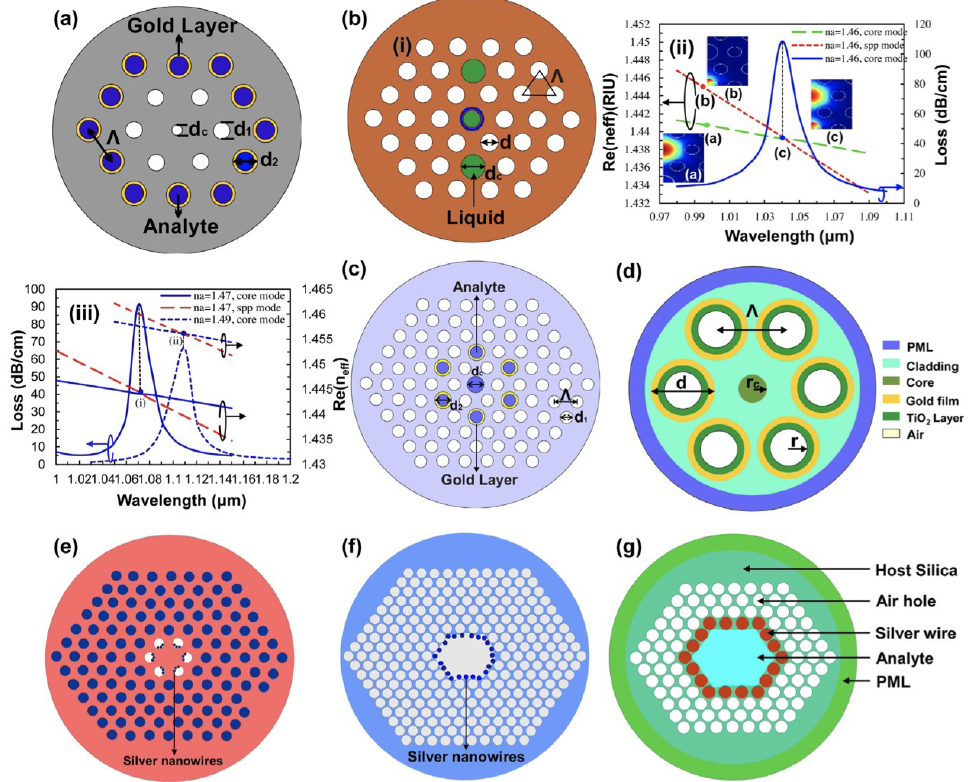
Figure 7. Metal coating-based plasmonic PCF sensors. ( a ) gold coated in the second ring ( d c = 0.45 Λ , d 1 = 0.6 Λ , d 2 = 0.8 Λ , Λ = 2 µm and gold layer thickness equal to 40 nm); ( b ) ( i ) selectively silver deposited core ( d c = 0.8 Λ , d 1 = 0.6 Λ , d 2 = 0.8 Λ , Λ = 2 µm and silver layer thickness equal to 40 nm), ( ii ) field distribution with phase matching phenomena; and ( iii ) phase matching phenomena shifted with varying analyte RI. ( c ) Selectively gold-coated with liquid-filled core ( d c = 0.8 Λ , d 1 = 0.5 Λ , d 2 = 0.8 Λ , Λ = 2 µm and gold layer thickness, t = 40 nm); ( d ) multiple holes coated with gold-TiO 2 layer ( r c = 3.5 µm, r = 6 µm, Λ = 13 µm, gold layer thickness equal to 30 nm and TiO 2 layer